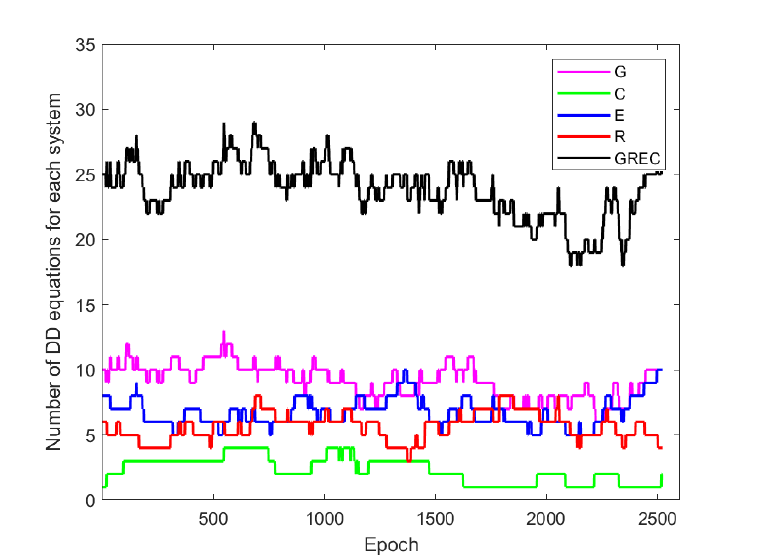
Figure 3. Number of DD equations for each system for baseline BRUX-DLF1 for 3-Jan-2021 (G: GPS, R: GLONASS, E: Galileo, C: